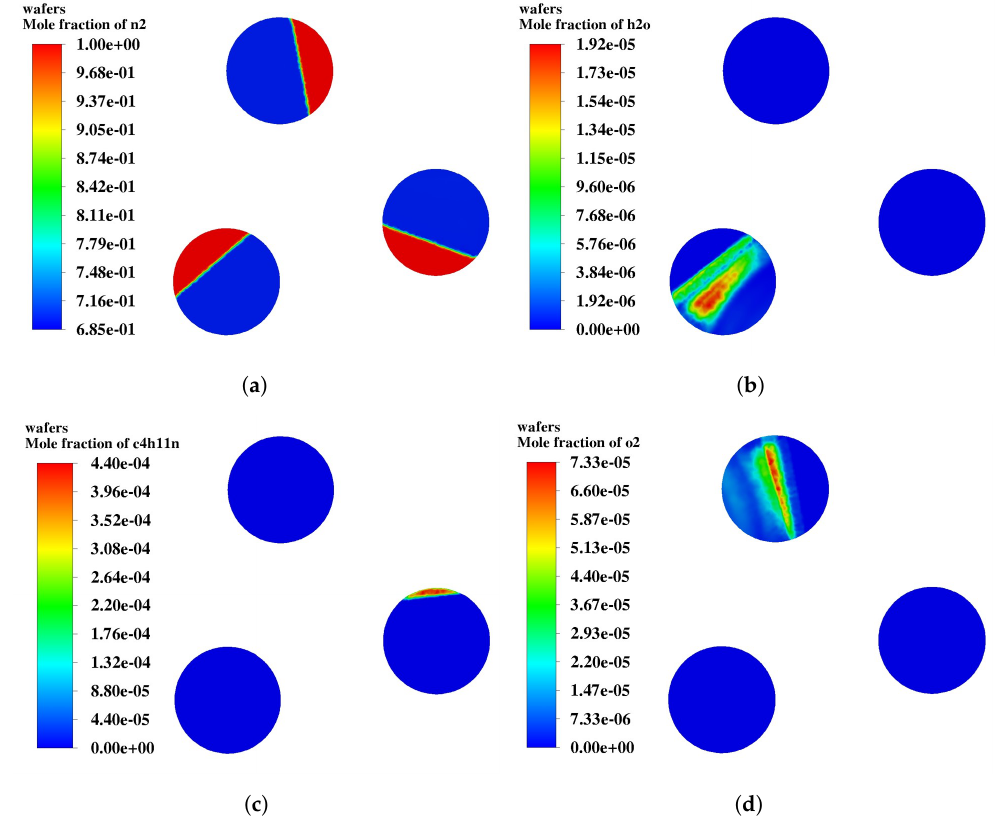
Figure 14. Contours of ( a ) Nitrogen mole fraction, ( b ) H 2 O mole fraction, ( c ) DEA mole fraction, and ( d ) O 2 mole fraction on the wafers at 2 s with 0.4 rad/s From bottom left counter-clockwise, the wafers in the Hacac, BDEAS, and ozone reaction zones,